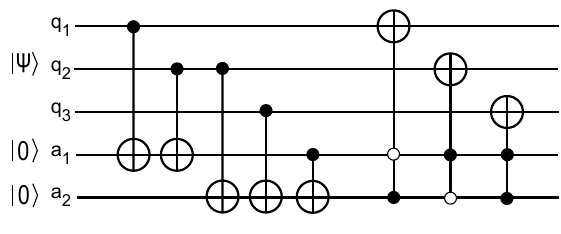
Figure 17: Circuit to detect and correct errors in the three-qubit bit-flip error code. Here we introduce a new set of gates, double-control CNOT gates (these are versions of the Toffoli gate). When the two controls are filled circles, the CNOT is applied when both controls are in the | 1 〉 state, while an empty circle means that control qubit must be in the | 0 〉 state for the CNOT to